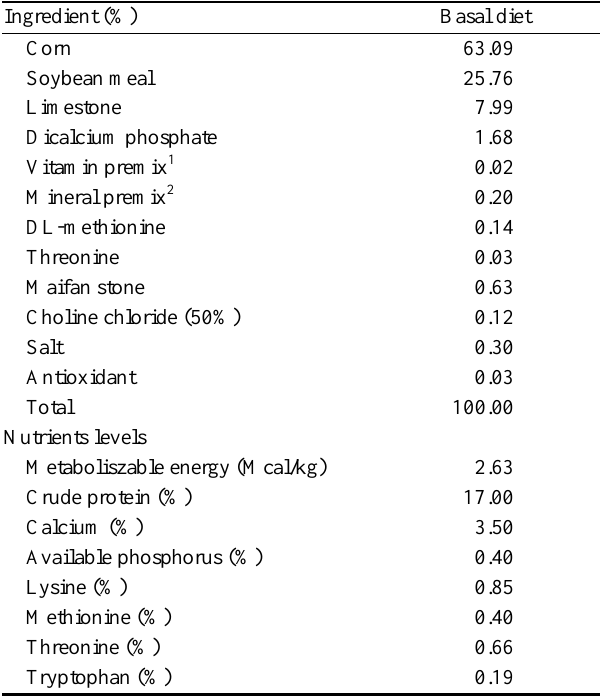
Table 1. The composition of basal diet and nutrients